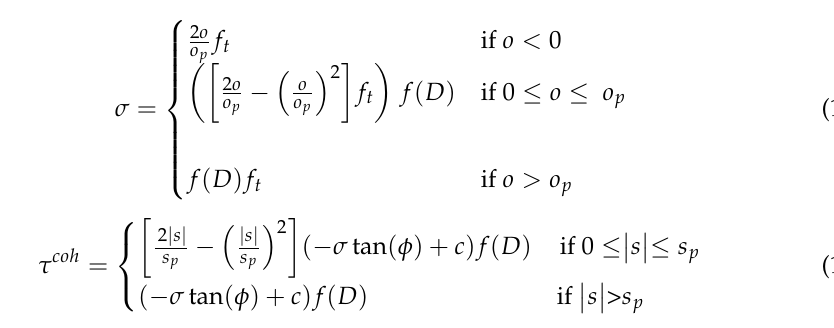
Figure 4. Curve of function f ( D )